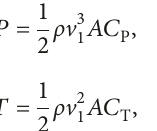
Figure 2: Basalt and glass fiber specimens after the norm ASTM D3039 test. (a) Basalt with fiber orientations 0/90. (b) Glass fiber with fiber orientations